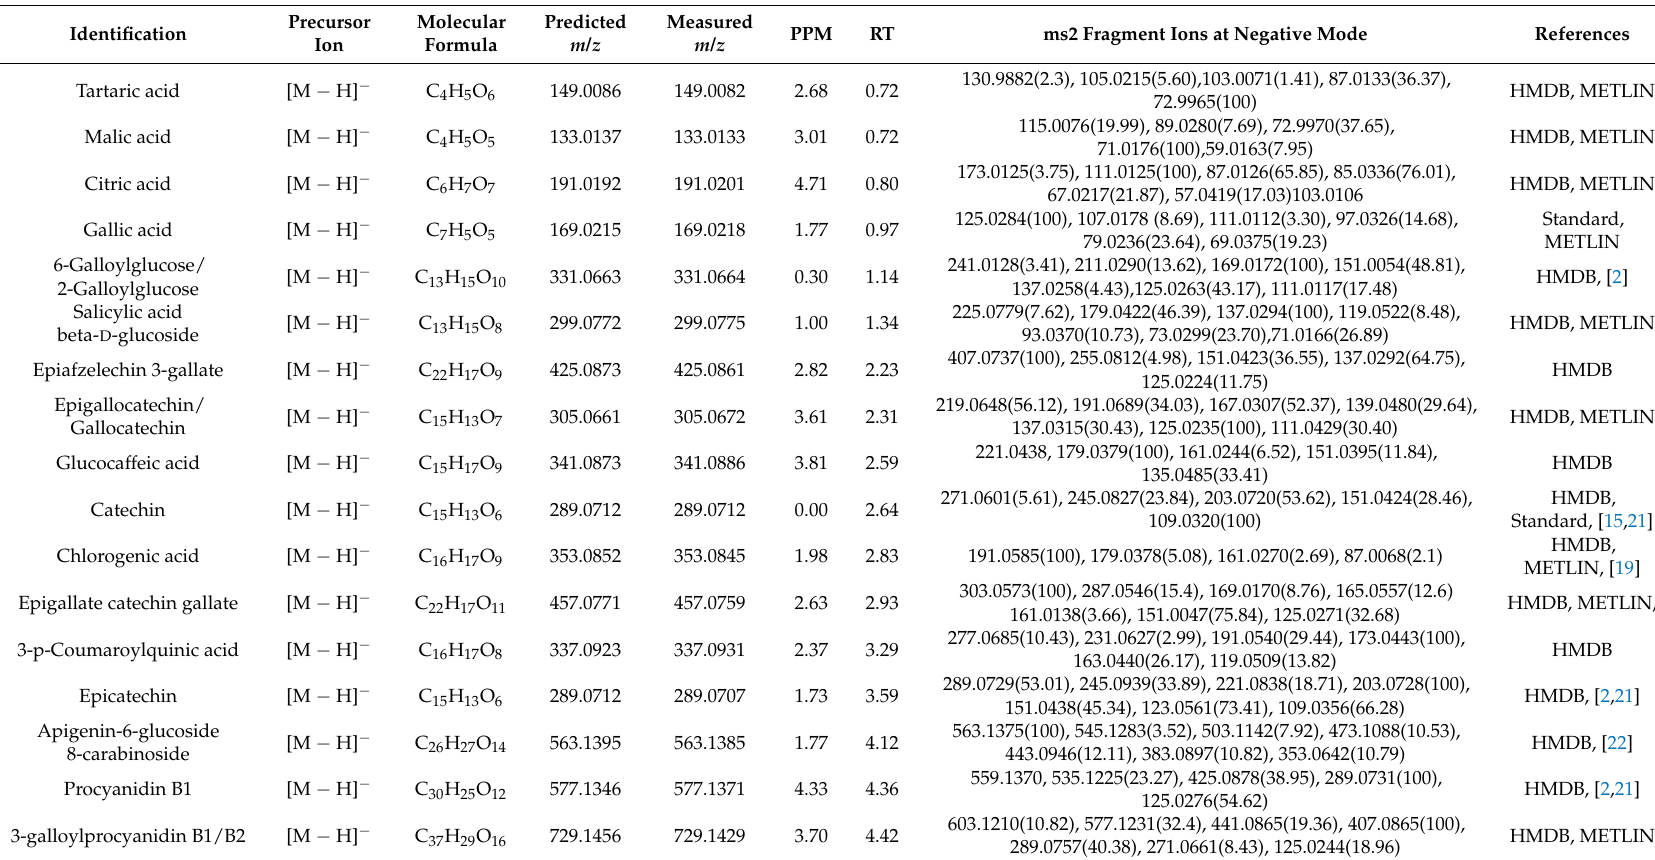
Table 1. Characteristic fragment ions, retention times and m / z of metabolites tentatively identified based on reference standard, published literature, METLIN or HMDB